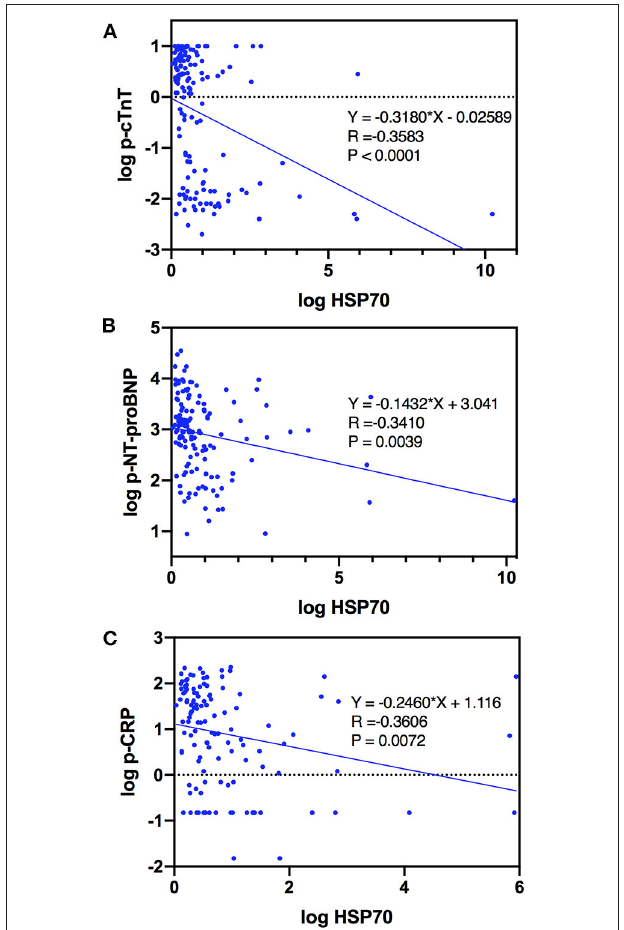
FIGURE 2 | Curve estimations of log HSP70 with (A) log p-cTnT, (B) log p-NT-proBNP, and (C) log p-CRP.